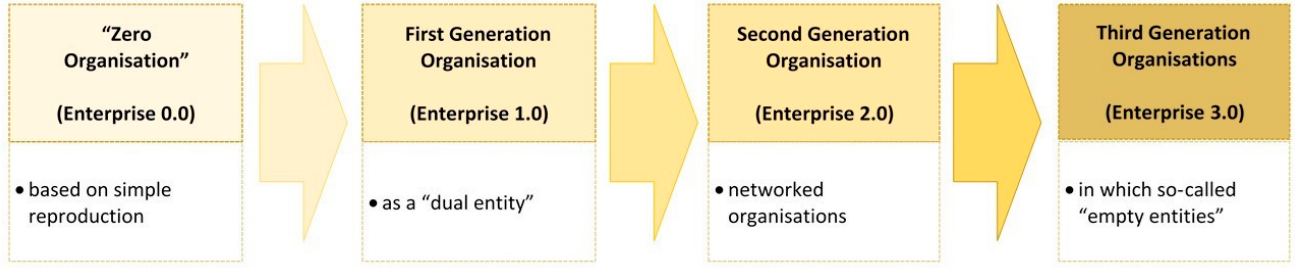
Figure 1. Evolution of market entities. Own-study based on [2] (pp. 21–22), [3,4], [5] (p. 33), [6,7].